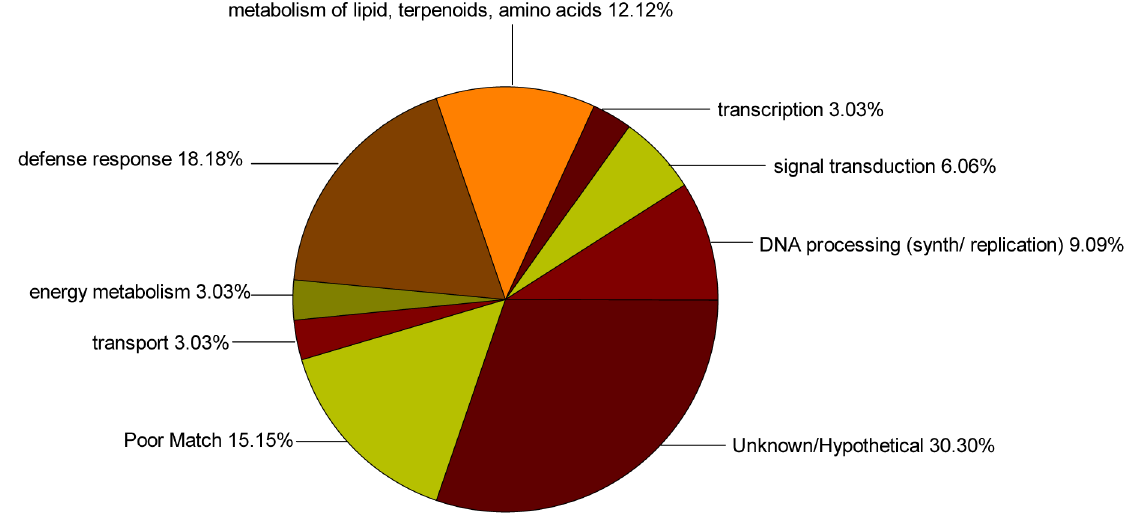
Figure 3. Functional classification of unigenes from the reverse SSH library within biological process category.